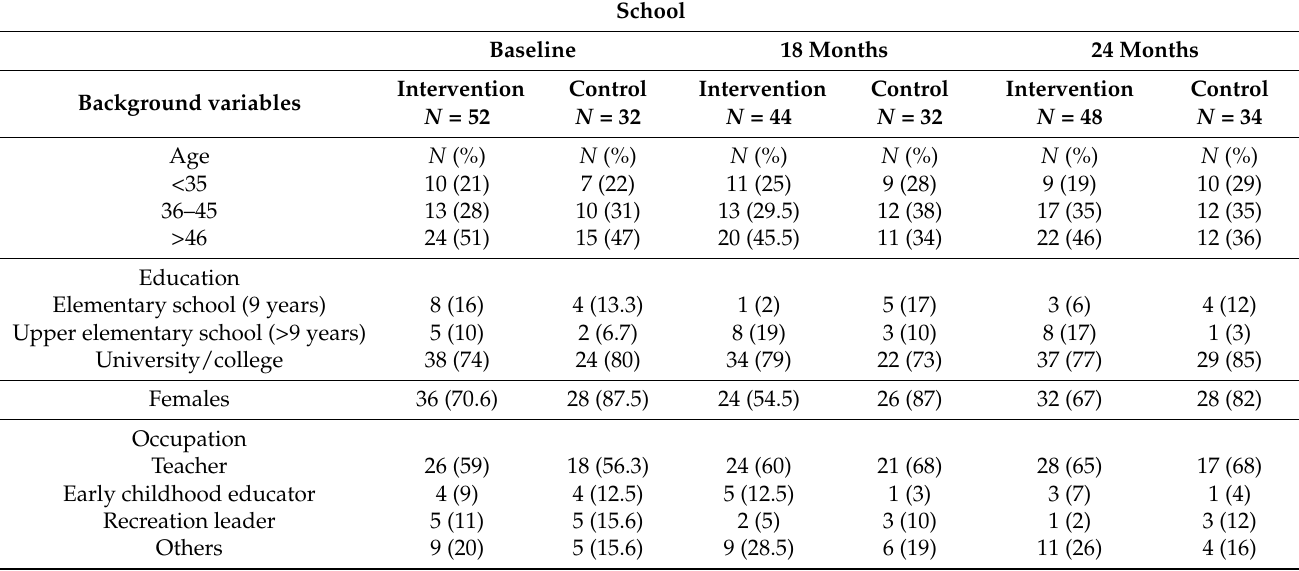
Table 2. Characteristics of study